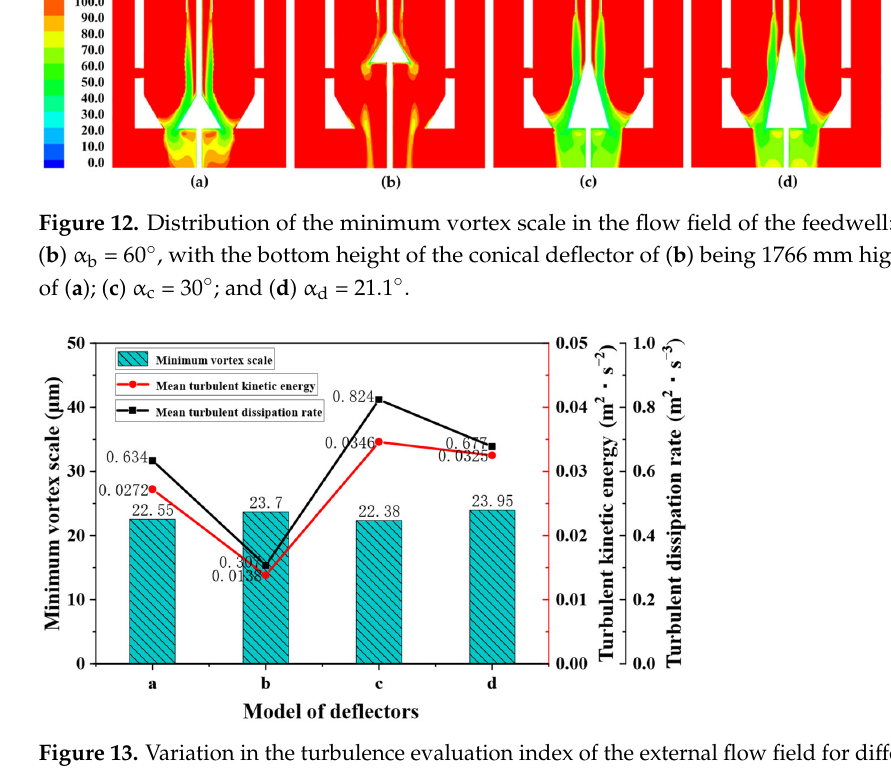
Figure 13. Variation in the turbulence evaluation index of the external flow field for different types of conical deflectors.